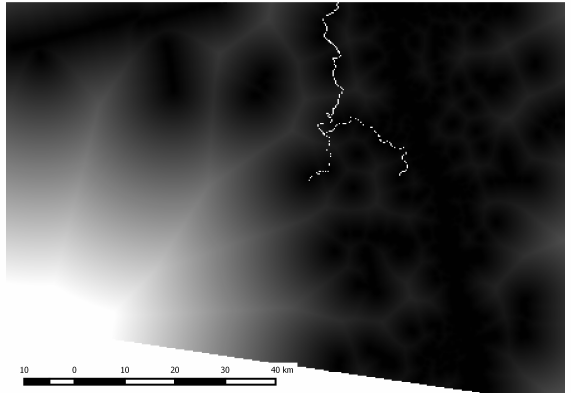
Figure 9: Map of distance from previously deforested area (1997). This map is updated at each modeling